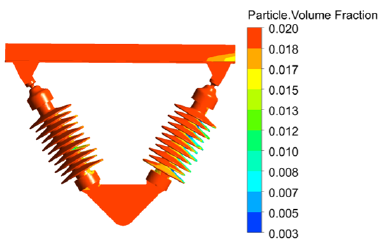
Figure 24. Distribution map of contamination on the surface of insulators.